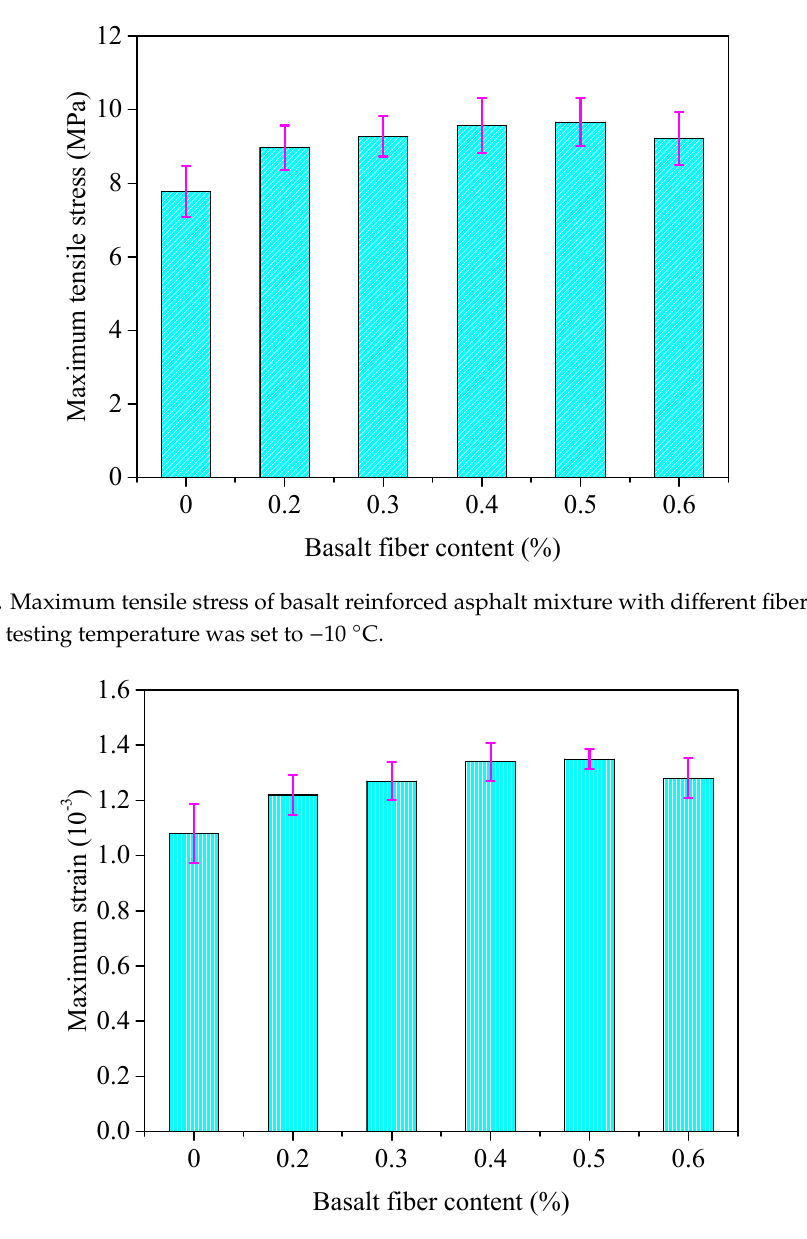
Figure 17. Maximum strain of basalt reinforced asphalt mixture with different fiber contents, where the testing temperature was set to − 10 °C.